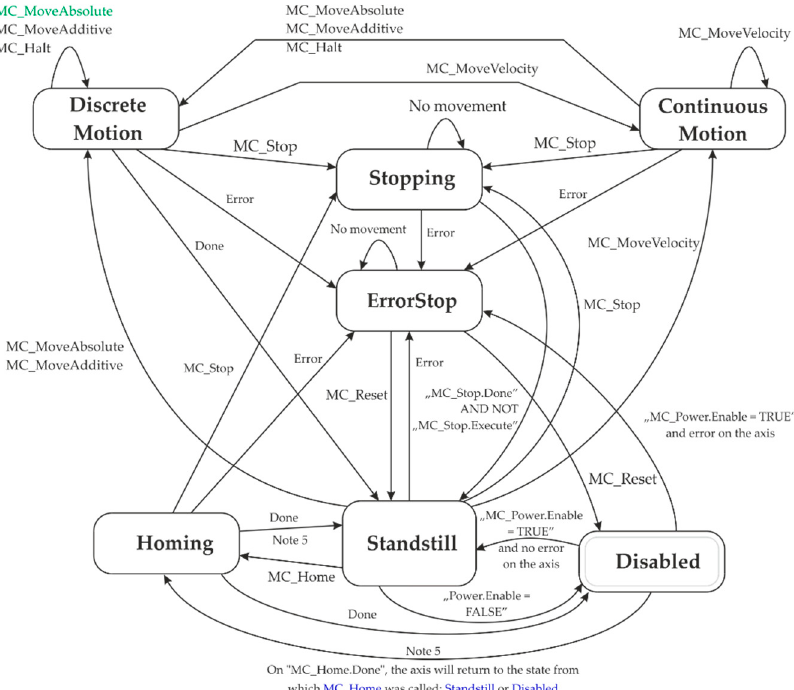
Figure 1. PLCopen Motion Control standard state execution state diagram.